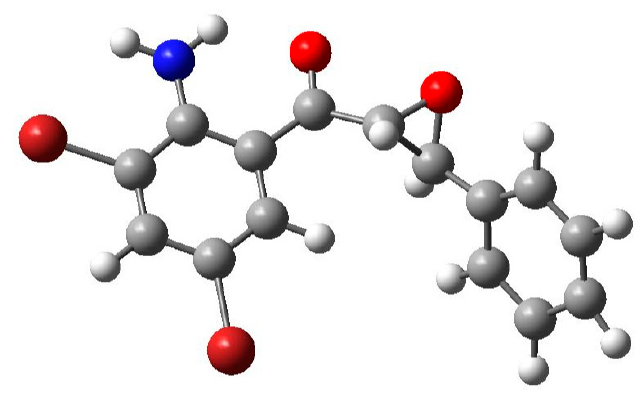
Figure 6. A view of the optimized structure of compound 2a . Table 2. Comparison of selected XRD and DFT bond lengths (Å) and angles (°) of 2a .